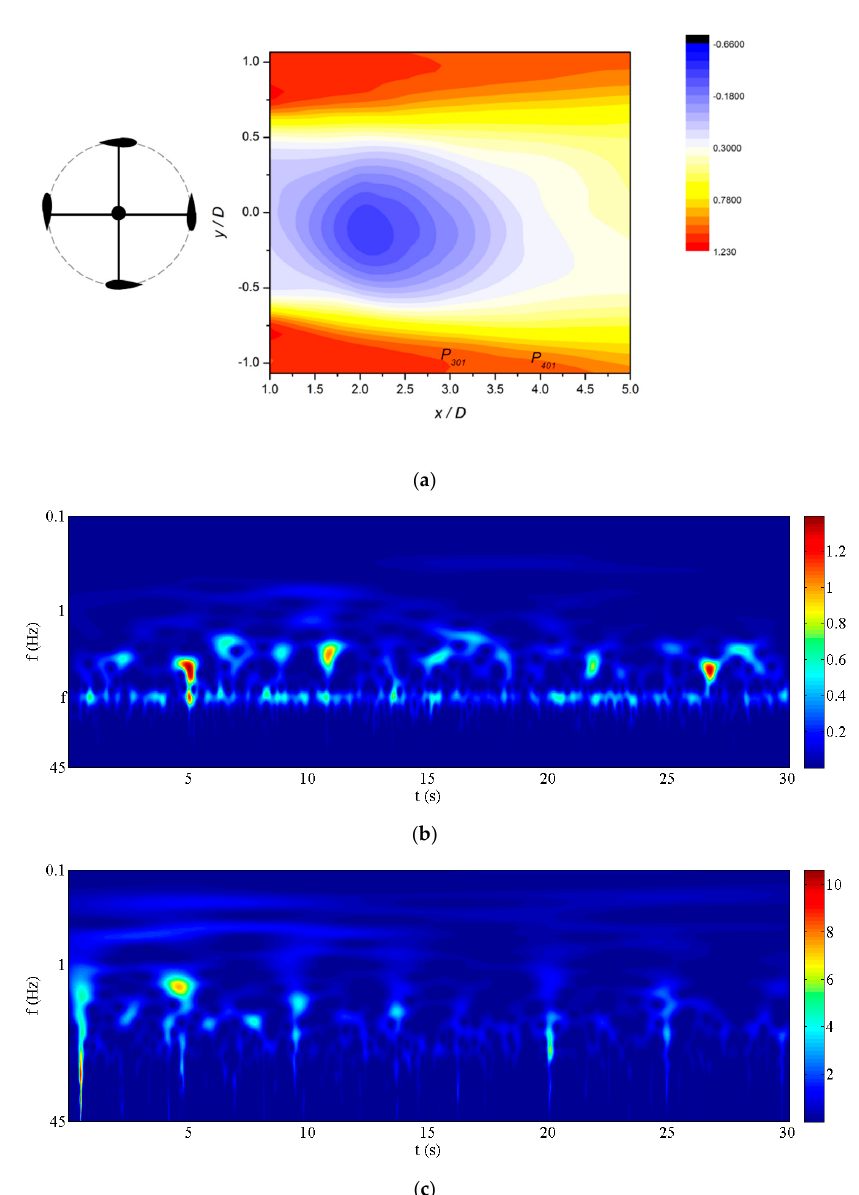
Figure 8. The wavelet spectrum of the time series signal of the streamwise fluctuating velocity at different positions of the turbine wake with configuration D, n = 4, c = 81mm: ( a ) schematic diagram, ( b ) P 301 , ( c ) P 401 . Since all the contour plots in this paper were the interpolation results of the measured velocity values, there were velocity information in the re-circulation regions. All the contour plots in this paper are only shown as schematic diagrams.